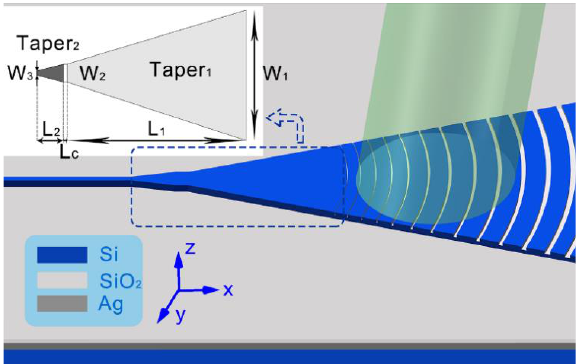
Figure 2. 3D schematic of the entire structure of the silicon HPW-fiber coupler. Here, the HPW has a bottom metal layer. Inset illustrates the details of the two-stage-taper mode converter. (The SiO 2 cladding layer is not shown in the 3D schematic).